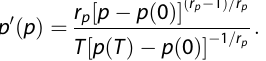
vs ramping index r J at J ( T ) = 0.5 and T = 5 π / g , gp